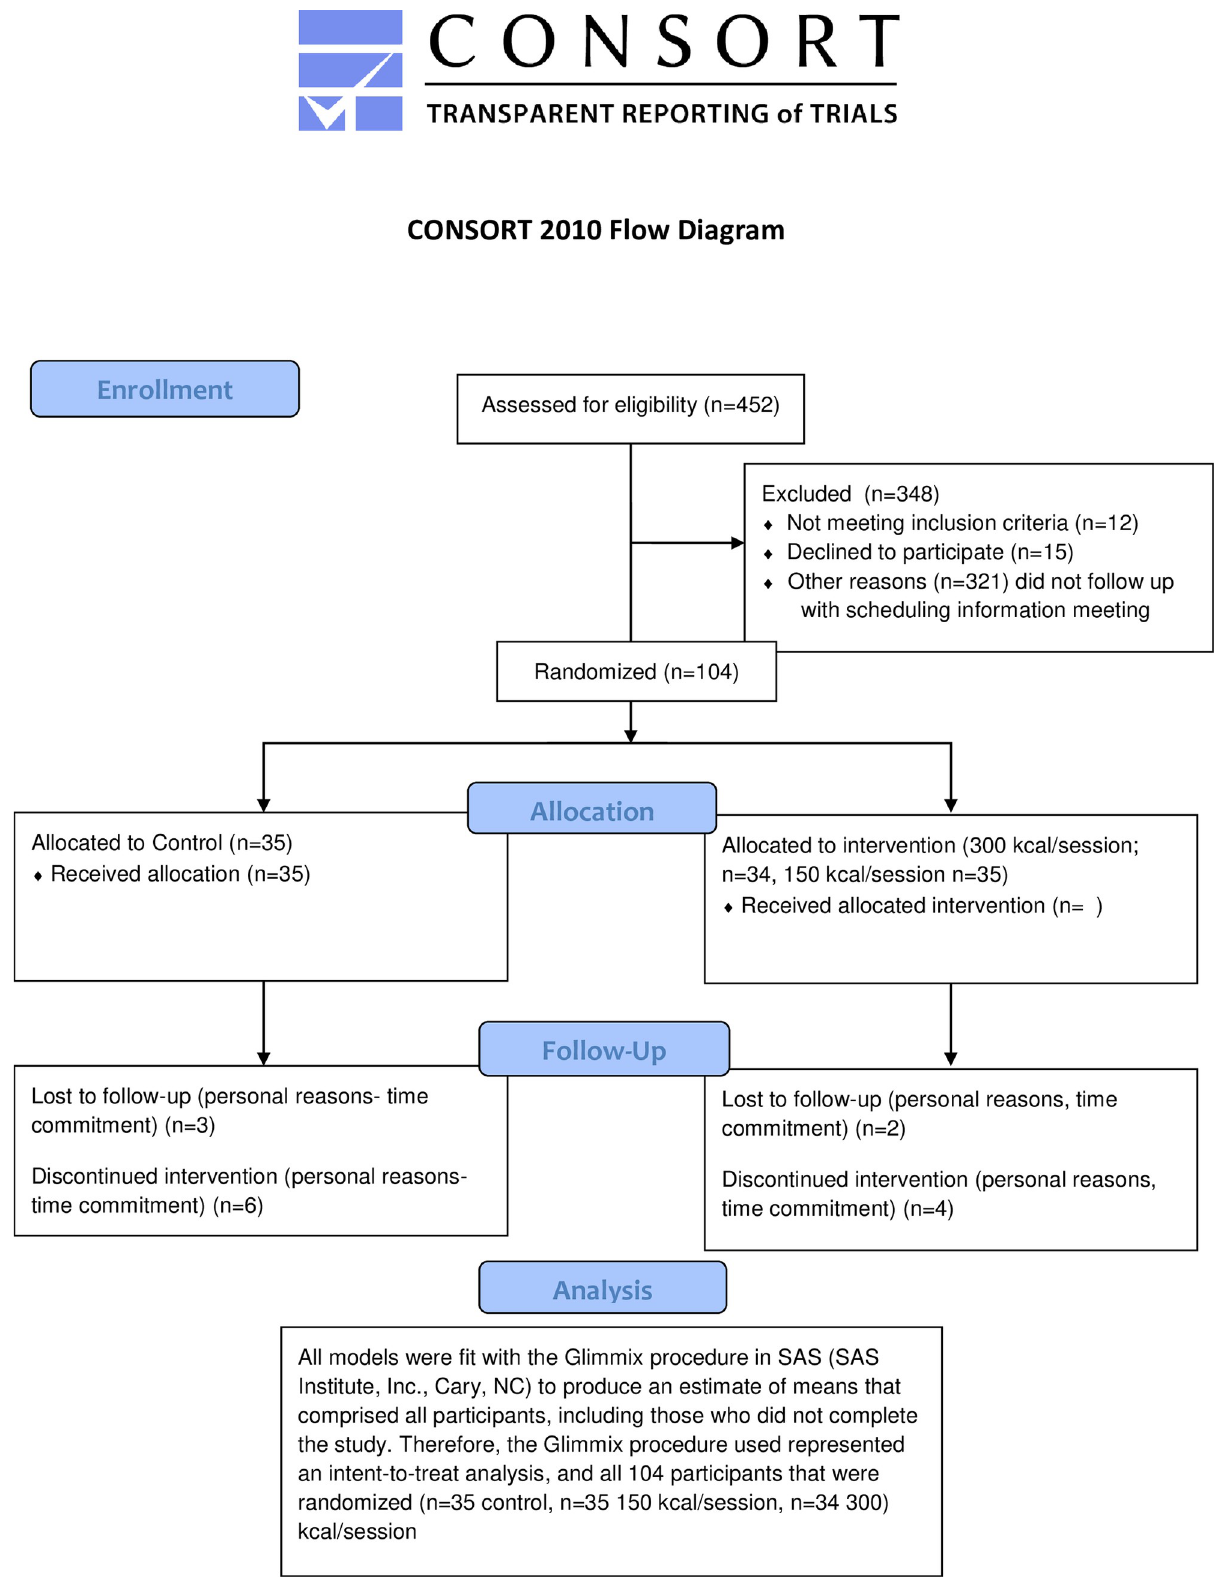
Fig 1. Consort flow diagram. https://doi.org/10.1371/journal.pone.0216355.g001 PLOS ONE | https://doi.org/10.1371/journal.pone.0216355 May 7,